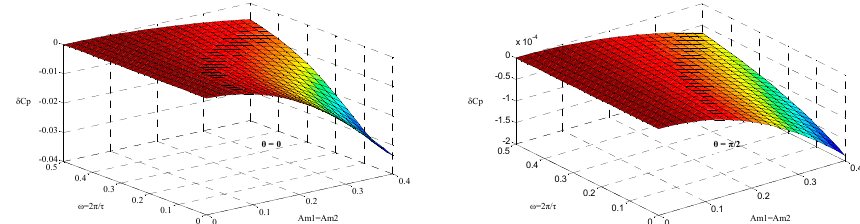
Figure 5. The first order offset of product concentration P with varying forcing amplitude and frequency, where the left hand side subplot is θ = 0 and the right hand side subplot is θ = π /2.